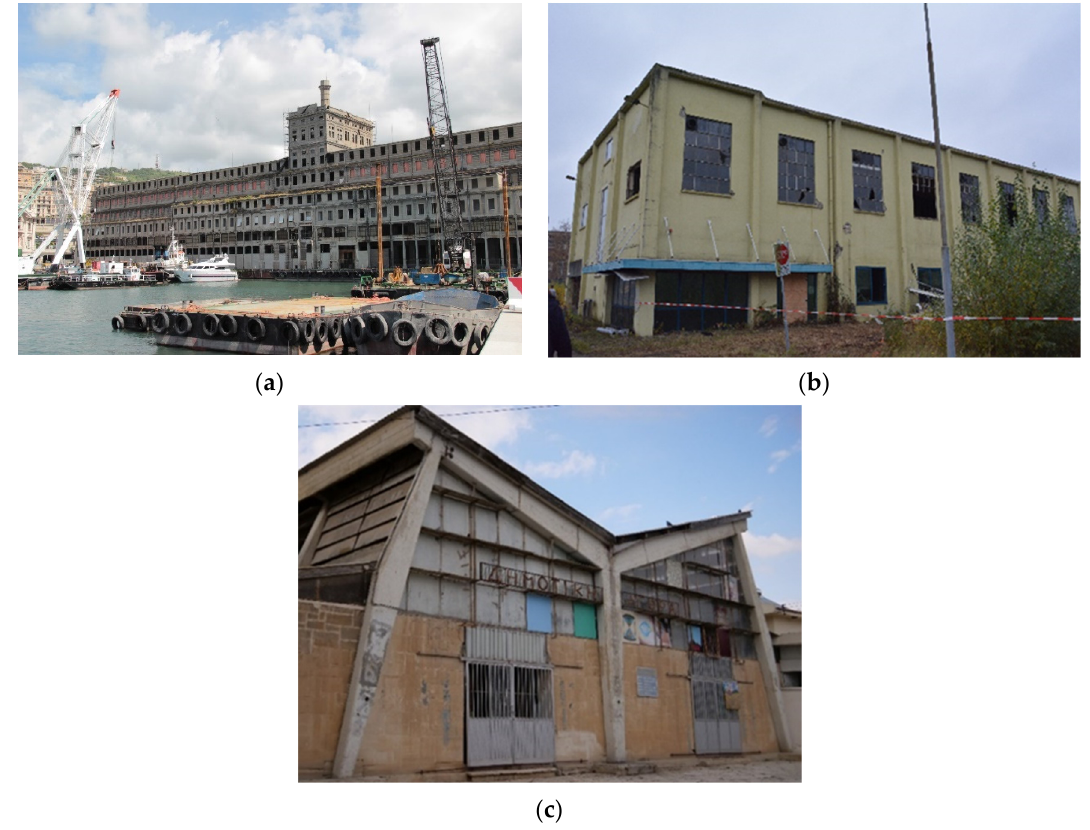
Figure 1. Historic concrete buildings. ( a ) Hennebique Silos in Genova (1901–1906). Source: Authors 6; ( b ) Calve Building (1908) in Delft, the Netherlands. Demolished in 2019. Source: Author 1; ( c ) Athienou Municipal Market (1951–1955) in Cyprus. Source: Authors 3 and 4.